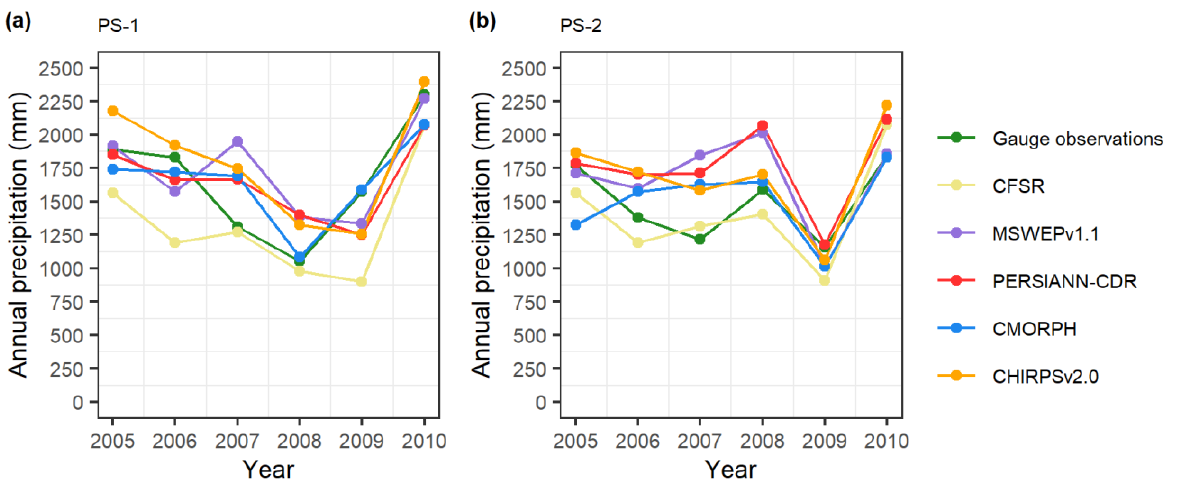
Figure 7. Annual precipitation in: ( a ) PS-1 station and ( b ) PS-2 station.